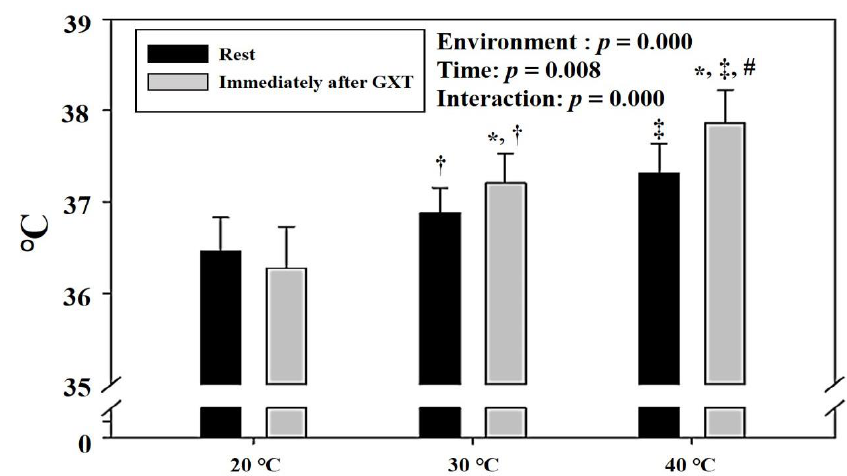
Figure 3. Changes in body temperature at rest and immediately after GXT (mean ± standard deviation). GXT: graded exercise test; a: significant difference immediately after GXT; *: significant difference between rest and immediately after GXT; †: significant difference between 20 °C and 30 °C; ‡: significant difference between 20 °C and 40 °C; #: significant difference between 30 ° C and 40 °C.